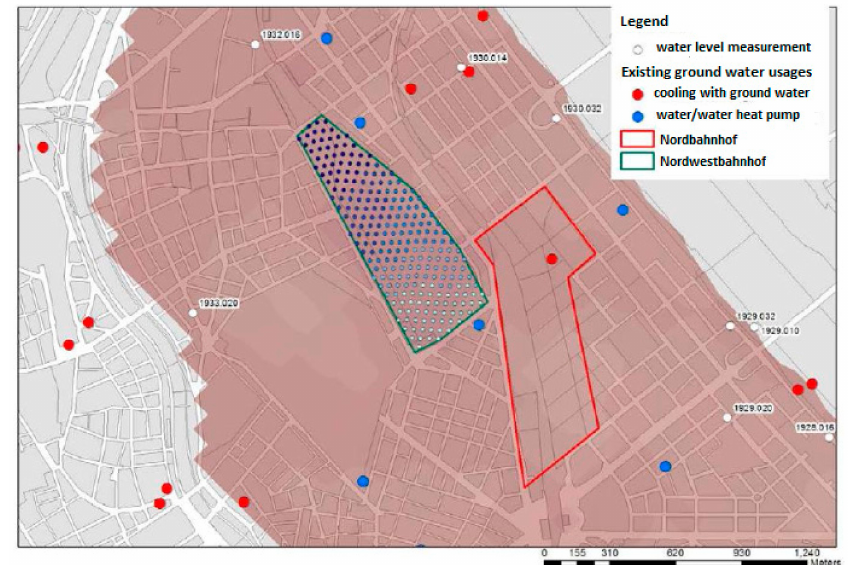
Figure 2. Existing ground water usages around Nordwestbahnhof, limiting the potential for a large ground water plant at Nordwestbahnhof, reproduced with the permission of [36], produced within the project “Urban PV + geotherm”, Goetzl, G.; Fuchsluger, M.